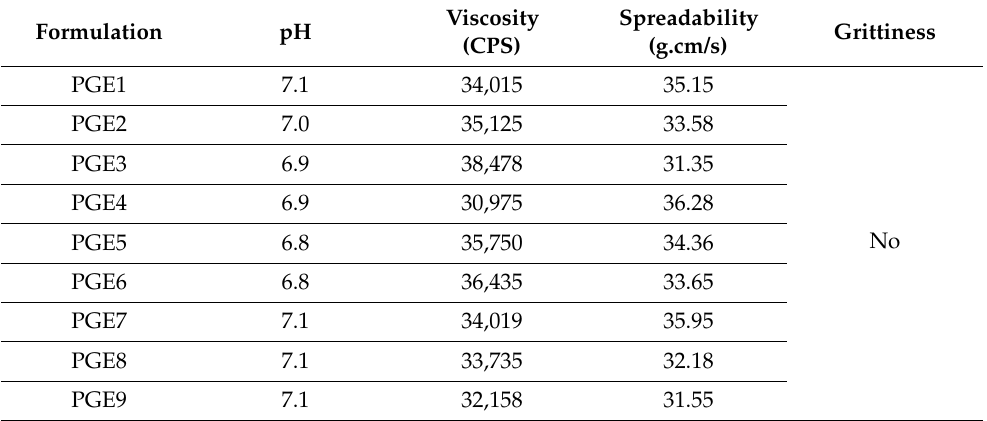
Table 3. Evaluation parameters of Punica granatum ethosome gel .